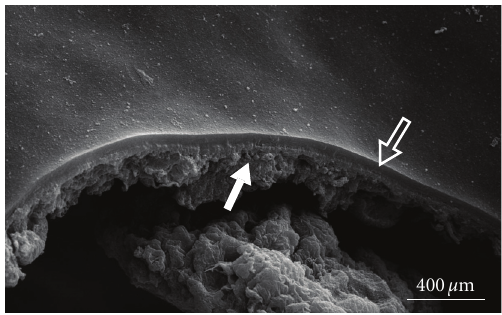
Figure 1: The laminated layer of Echinococcus multilocularis . Scanning electron microscopic visualization of an Echinococcus multilocularis metacestode vesicle trans-section: hollow arrow indi- cates outer laminated layer, white arrow indicates the inner germinal layer (Photo: A. Hemphill, IPB, Bern,